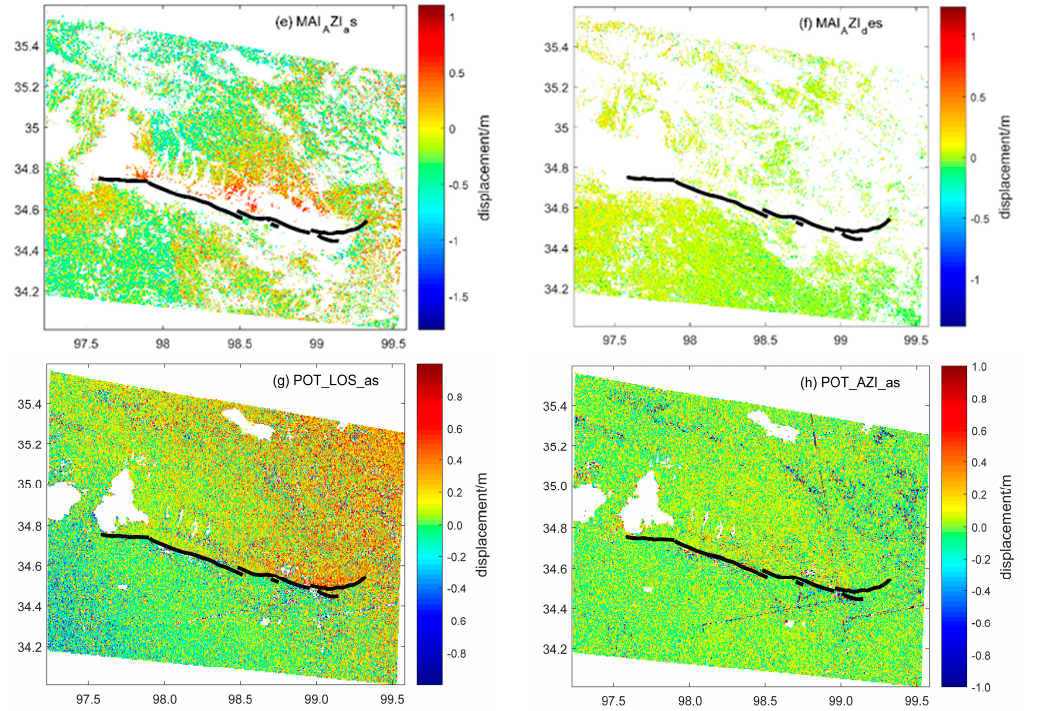
Figure 3. The LOS and azimuthal deformations obtained by the DInSAR, MAI and POT, the x − axis represents the east longitude (E), unit is the degree ; the y -axis represents the north latitude (N), unit is the degree; ( a ) DInSAR_LOS_as; ( b ) DInSAR_LOS_des; ( c ) MAI_LOS_as; ( d ) MAI_LOS_des; ( e ) MAI_AZI_as; ( f ) MAI_AZI_des; ( g ) POT_LOS_as; ( h ) POT_AZI_as. For example, DInSAR_LOS_des indicated the descending LOS deformation obtained by DInSAR technique; the black line represents the surface rupture in field, which is agree with the InSAR measurement results.